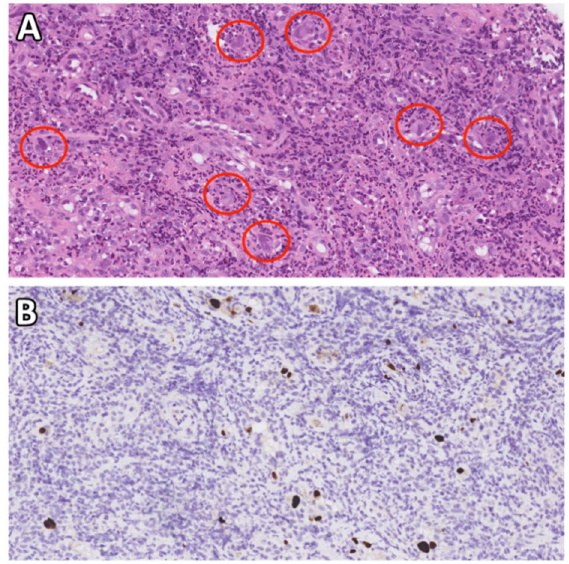
Figure 1. Diagnosis of CMV esophagitis using CMV IHC staining and/or CMV inclusion bodies in H&E staining. ( A ) H&E staining (40× objective) showing typical intranuclear (owl’s eye) and intracytoplasmic (eosinophilic punctiform) CMV inclusions within the circles. ( B ) IHC staining (40× objec- tive) with 1:200 diluted Novocastra™ lyophilized mouse monoclonal antibody against CMV pp65 antigen shows strong focal CMV immunoreactivity with brownish areas.